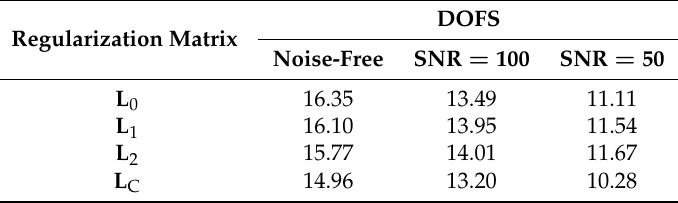
Table 2. Degree of freedom for signal (DOFS) for case